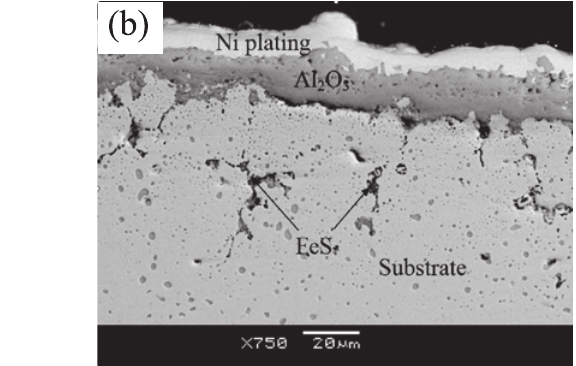
Fig. 4: XRD pattern (a) and cross-sectional morphology (b) of the VA alloy after hot corroded for 24 h